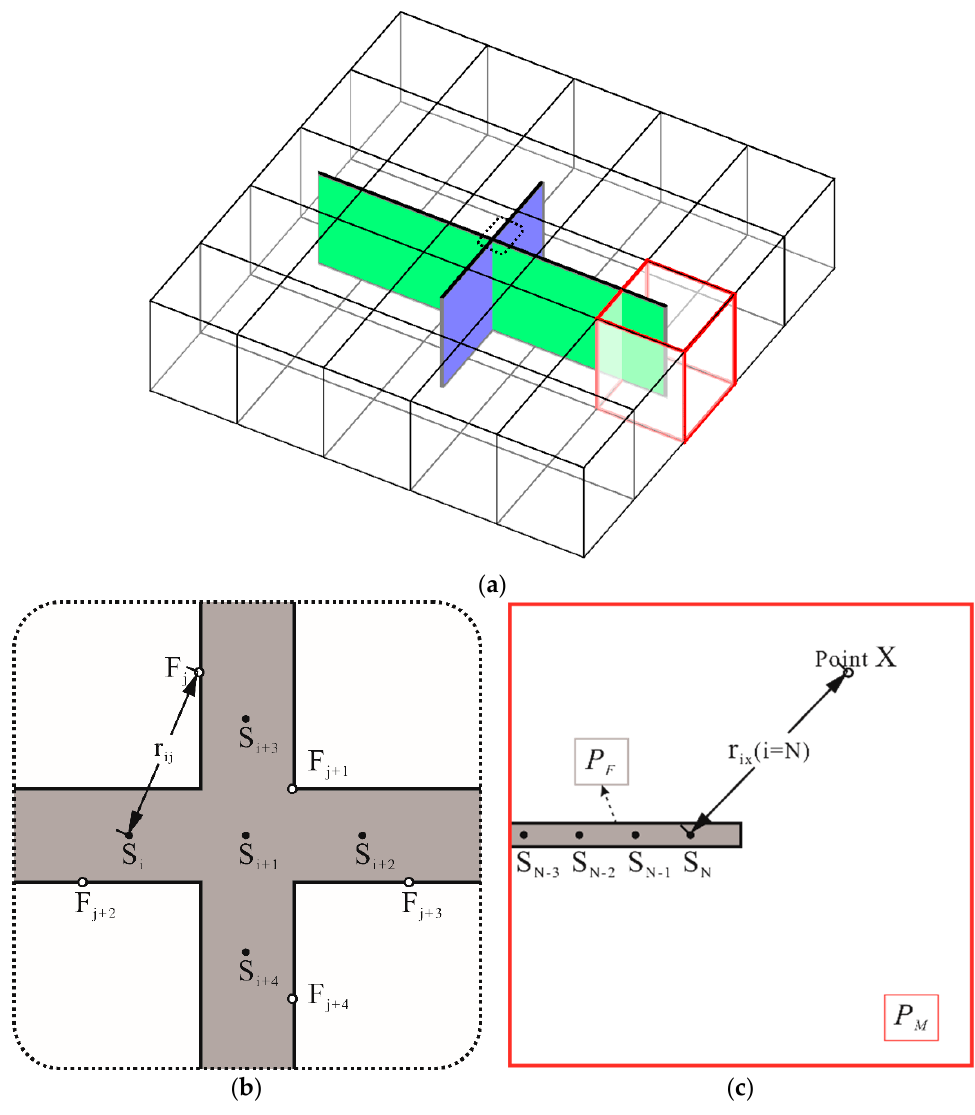
Figure 3. Illustration showing the calculation of M–F transmissibility in iEDFM: ( a ) a 2D example of the fractured reservoir; ( b ) the top view of the dotted frame part; and ( c ) the top view of the red matrix block.